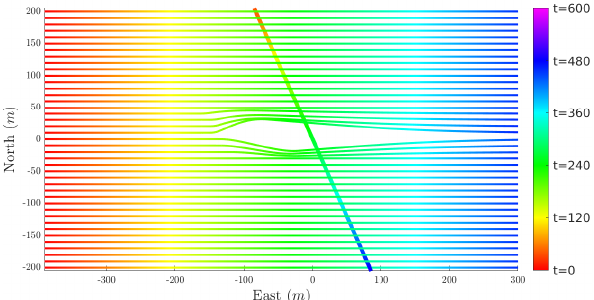
Figure 11: Batch 3: Stand-on crossing.